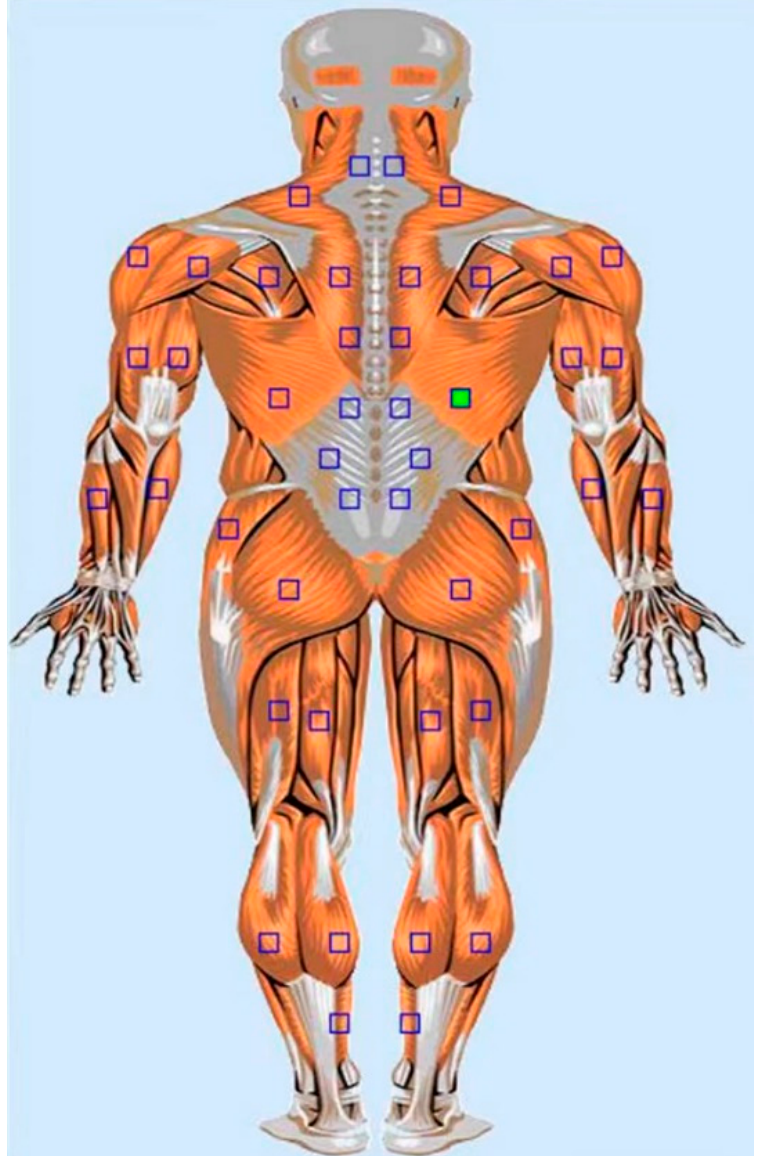
Figure 2. The position on latissimus dorsi in the test manual to place electrodes shows as a green dot.